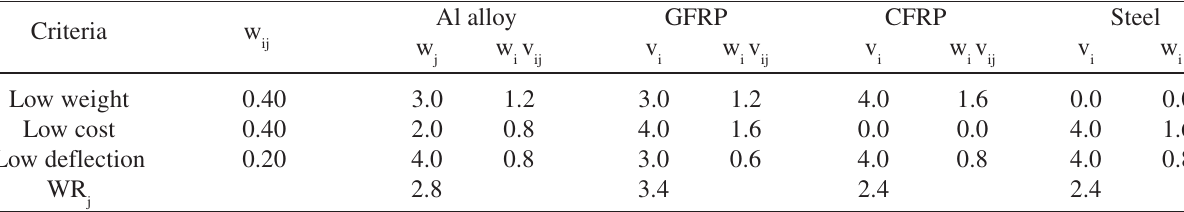
Table 2. Results of the Pahl & Beitz method applied to the sprayer support.